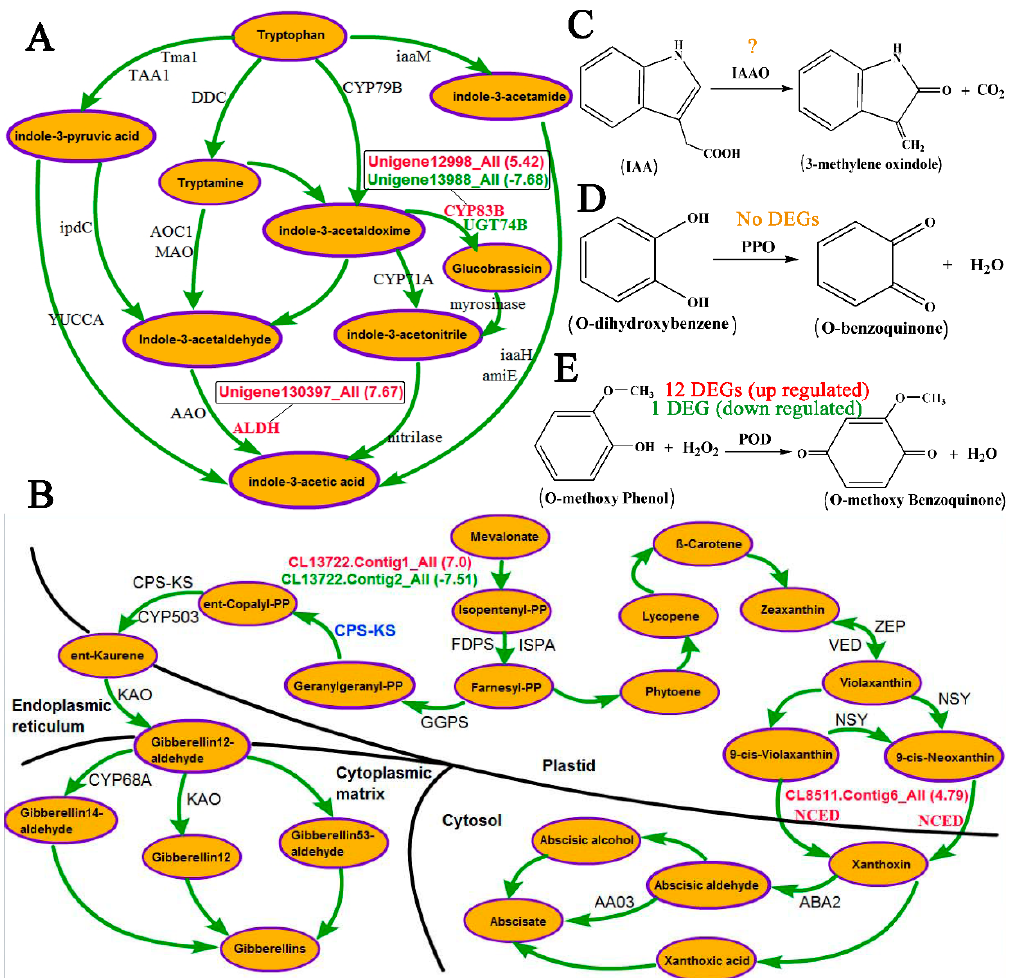
Figure 7. Effects of inversion on the IAA, ABA, and GA pathways and the catalytic reactions of IAAO, PPO, and POD. ( A ) The biosynthesis of IAA. ( B ) The biosynthesis of ABA and GA. ( C ) The reaction catalyzed by IAAO. ( D ) The reaction catalyzed by PPO. ( E ) The reaction catalyzed by POD. Red font indicates an upregulated unigene(s) or enzyme(s). Green font indicates a downregulated unigene(s) or enzyme(s). Blue font indicates the enzymes associated with both upregulated and downregulated unigenes. Yellow font indicates the enzymes with no unigenes.